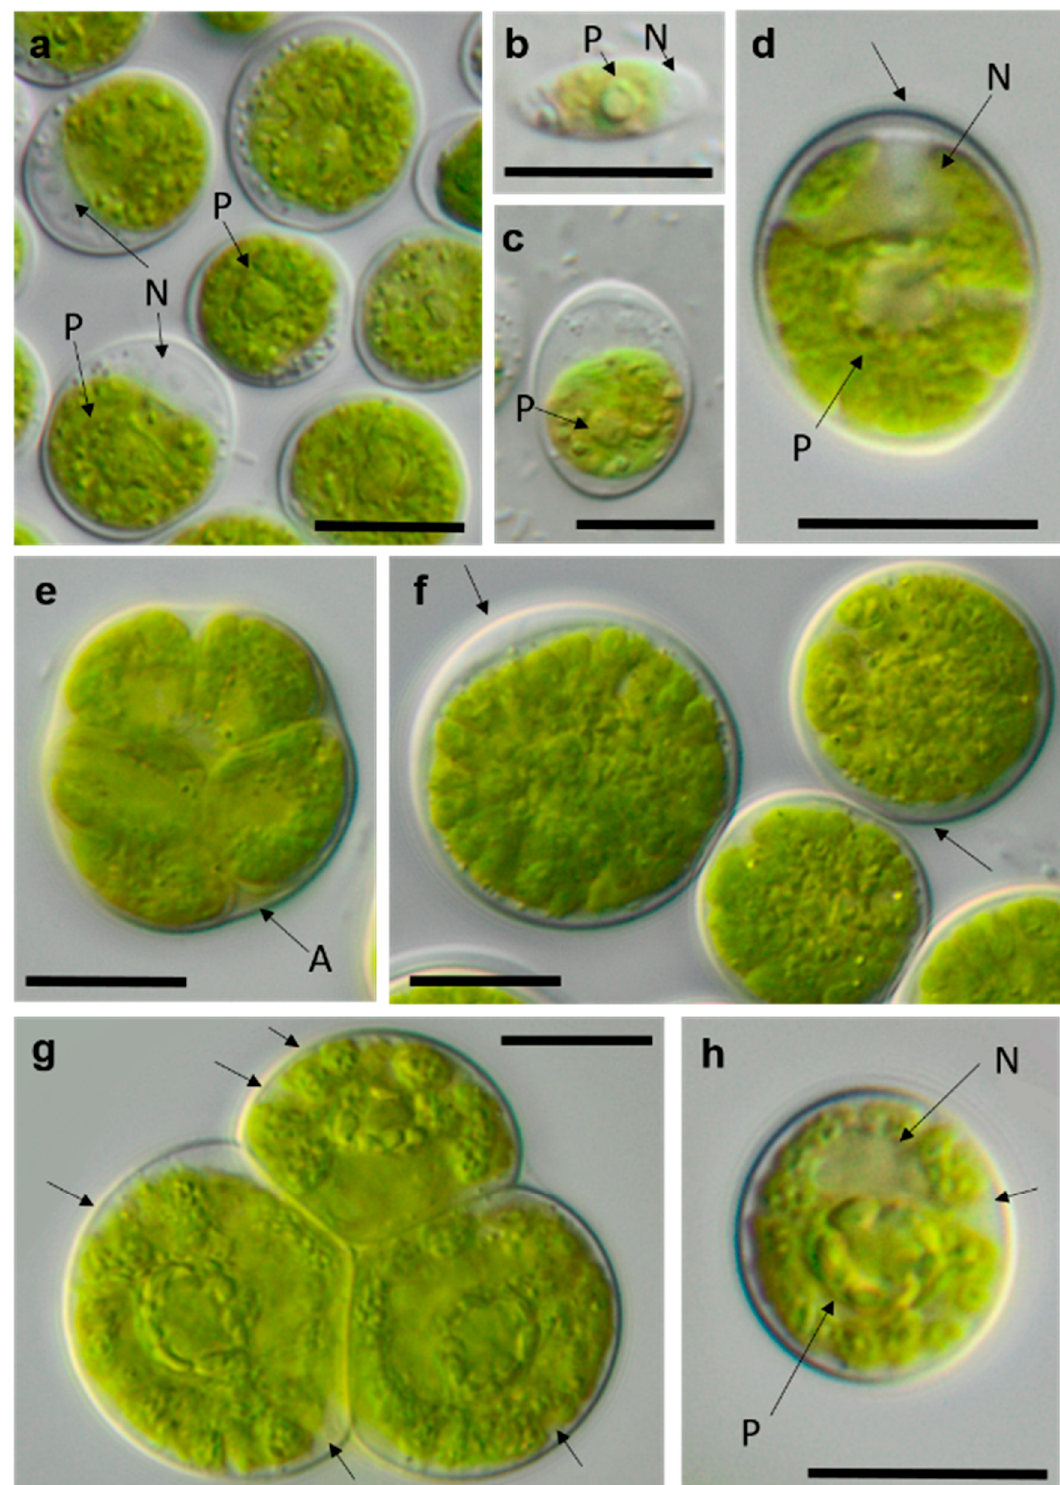
Figure 16. Photomicrographs of Chlamydomonadales isolates (2). ( a – c ) cf. Chlorogonium SY-1-2-T ( a ) mature cells and ( b ) zoospore; ( d – f ) Chloromonas sp. WT-3-1-F ( d ) young cell, ( e ) zoosporangium, and ( f ) mature cell with apical cell wall bulge (arrow); and ( g , h ) cf. Axilosphaera NN-1-1-Q, arrows indicating slightly open spaces between chloroplast lobes ( g ) adult cells in tetrad and ( h ) young cell. Arrow labels: N = nucleus and P = pyrenoid. Scale bars: 10 µm.